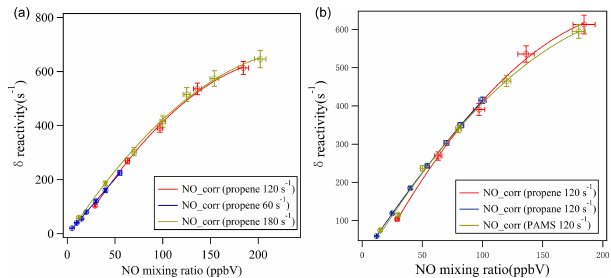
Figure 3. NO-correction experiments and fitting curves in Heshan in 2014. (a) NO-correction experiments with different mixing ra- tios of propene standard gas; (b) NO-correction experiments with different standard gases at the same reactivity level: 120s − 1 . Error bars stand for estimated uncertainty of the NO mixing ratios and difference in